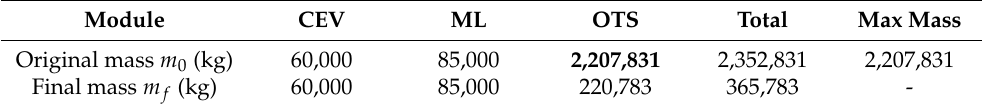
Table 6. Mass scale of Architecture-1.